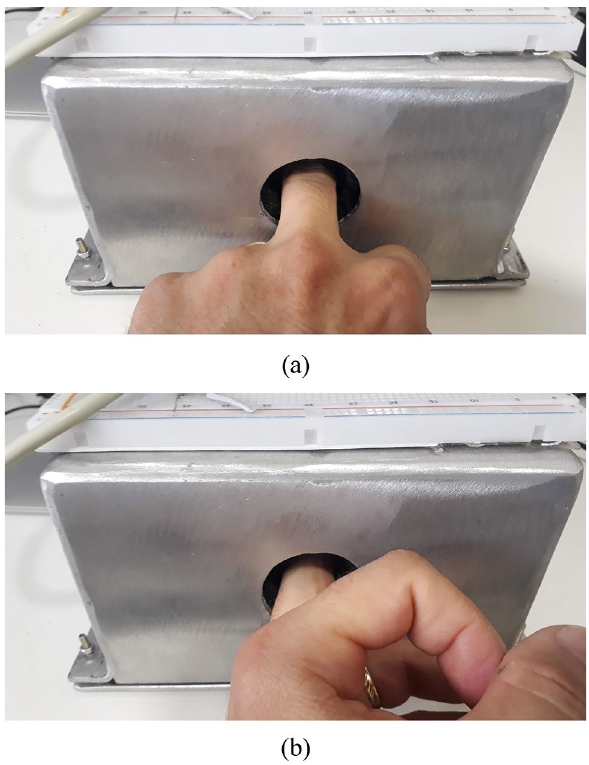
Figure 10. Insertion of middle finger in positions: ( a ) correct and ( b )